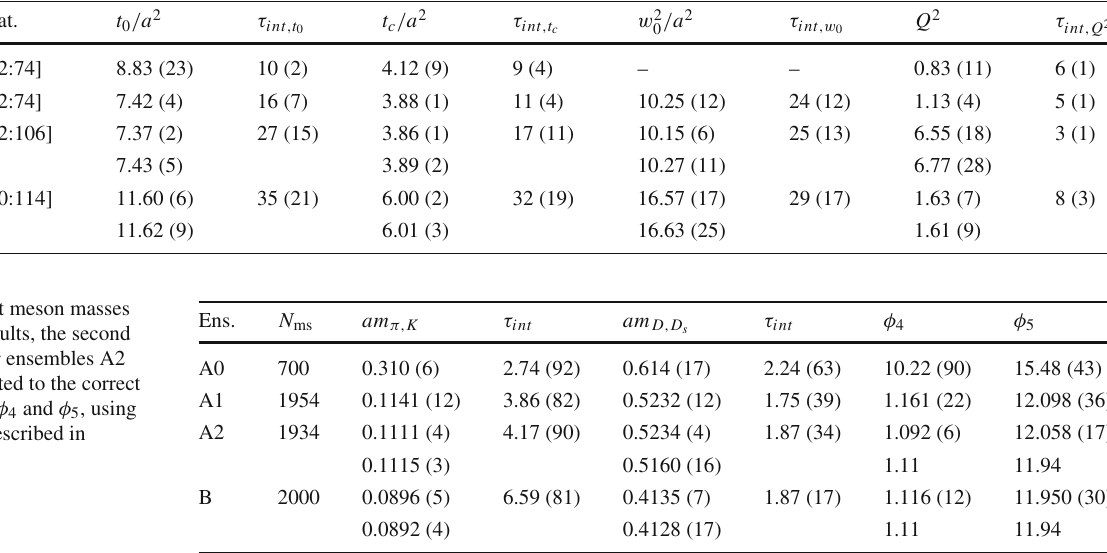
ond row values for ensembles A2 and B are shifted to the correct tuning points φ 4 and φ 5 , using the strategy described in Sect. 3.3, Eq. (3.20)